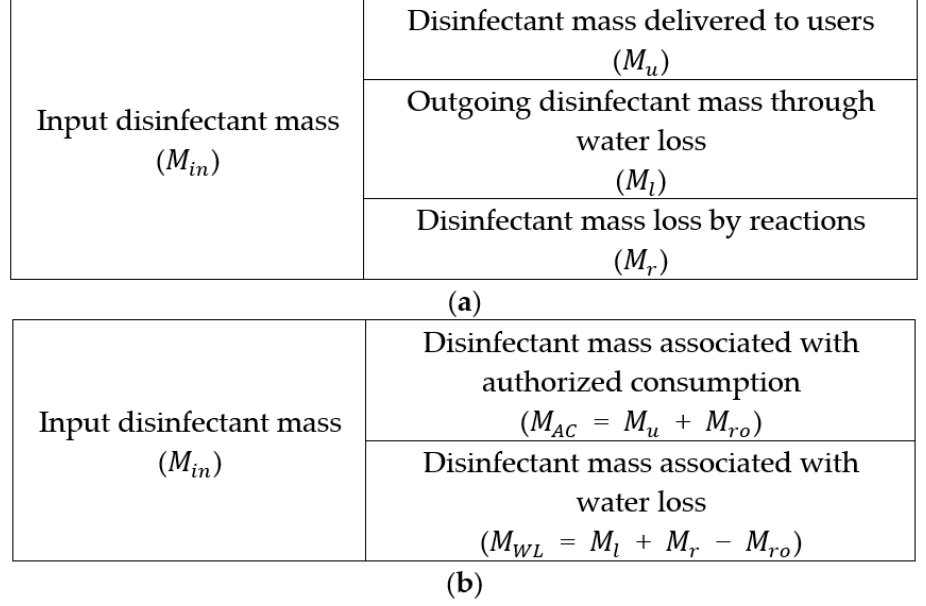
Figure 1. Two disinfectant mass balance concepts in water networks, considering water loss and reactions, focusing on: ( a ) processes and ( b ) the effect of water loss, where M ro is the disinfectant mass loss by reactions in the case of no water losses. Each component has a unit of mass per period of time, for example, kg/day.